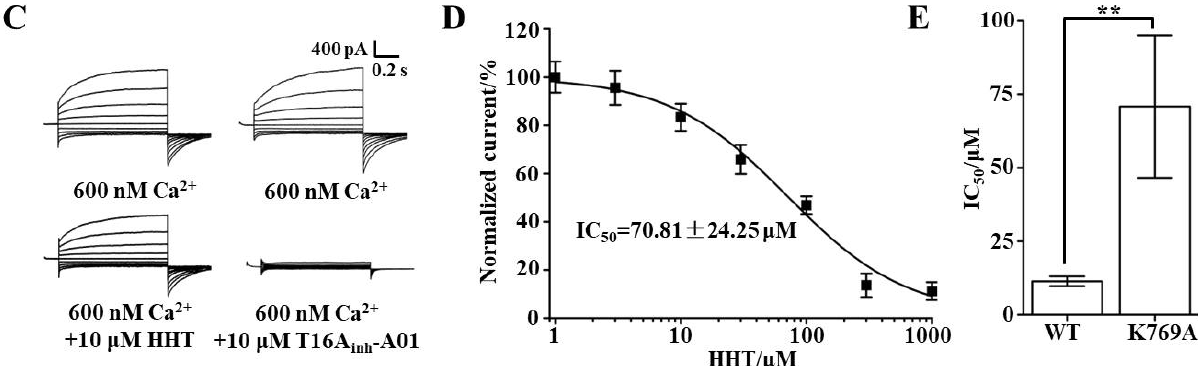
Figure 3. The binding site of HHT and TMEM16A. ( A ) Molecular structure of HHT and T16A inh -A01. ( B ) The putative binding site of HHT or T16A inh -A01 and TMEM16A. ( C ) Typical currents of HHT and T16A inh -A01 inhibited TMEM16A mutant ( n = 5). ( D ) Dose-response curve for HHT inhibition of TMEM16A mutant currents ( n = 5). ( E ) Statistical results of IC 50 value of HHT to wild-type TMEM16A and mutant currents ( n = 5, ** p < 0.01).